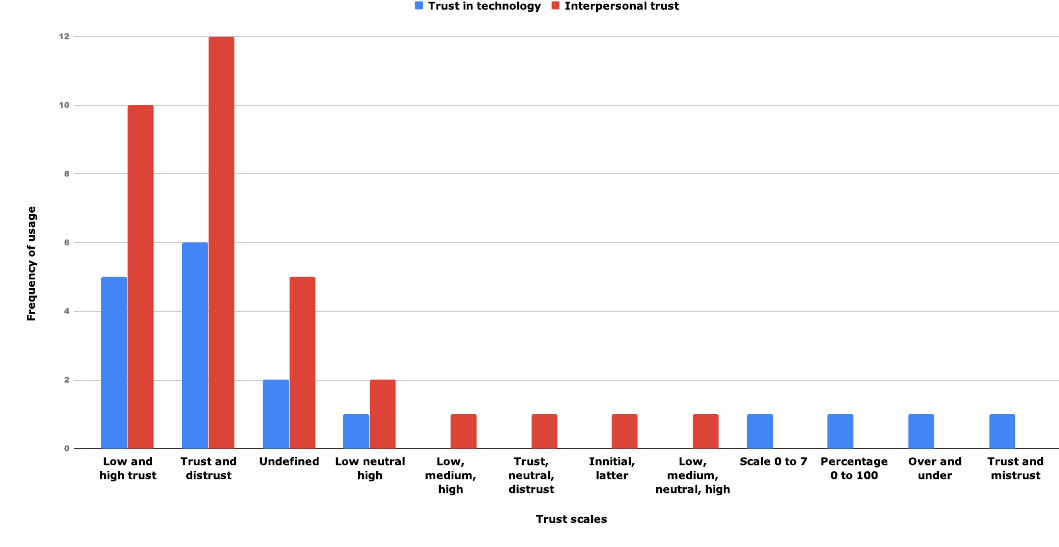
Figure 12. Frequency of usage of different trust scales in studies assessing trust with psychophysiological signals by context (trust in technology and interpersonal